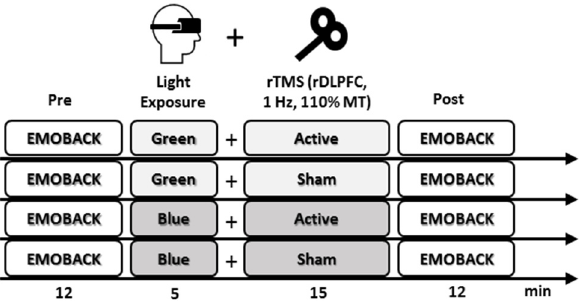
Figure 1. Schematic illustration of the experimental within-subjects design. Emotional n-back (EMOBACK) task performance was measured at baseline (Pre) and after light exposure (green/blue), combined with low-frequency repetitive transcranial magnetic stimulation (rTMS) (active/sham) applied over the right dorsolateral prefrontal cortex (DLPFC) (Post).